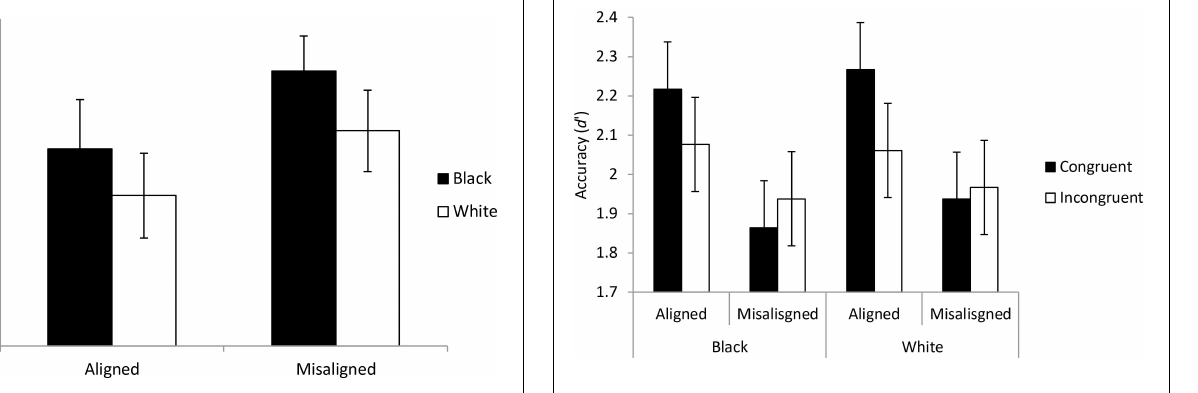
FIGURE 7 | Data used for the standard analysis in Experiment 2. The figure shows the proportion of correct responses when the bottom halves of the faces were the same but the top halves were different. The data were split according to whether the faces were aligned or not and the racial context of the faces. Error bars show ± one standard error.